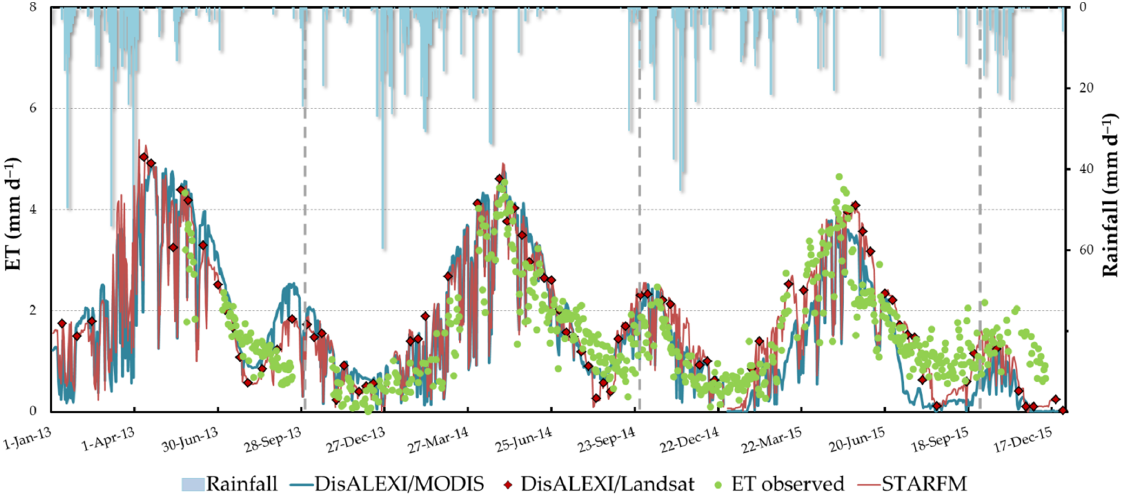
Figure 5. ET time series over the dehesa ecosystem from DisALEXI/MODIS, DisALEXI/Landsat, STARFM approach and observed data with closure correction for 2013, 2014 and 2015. Blue bars illustrate rainfall events and gray vertical lines indicate the starting of a hydrological year.